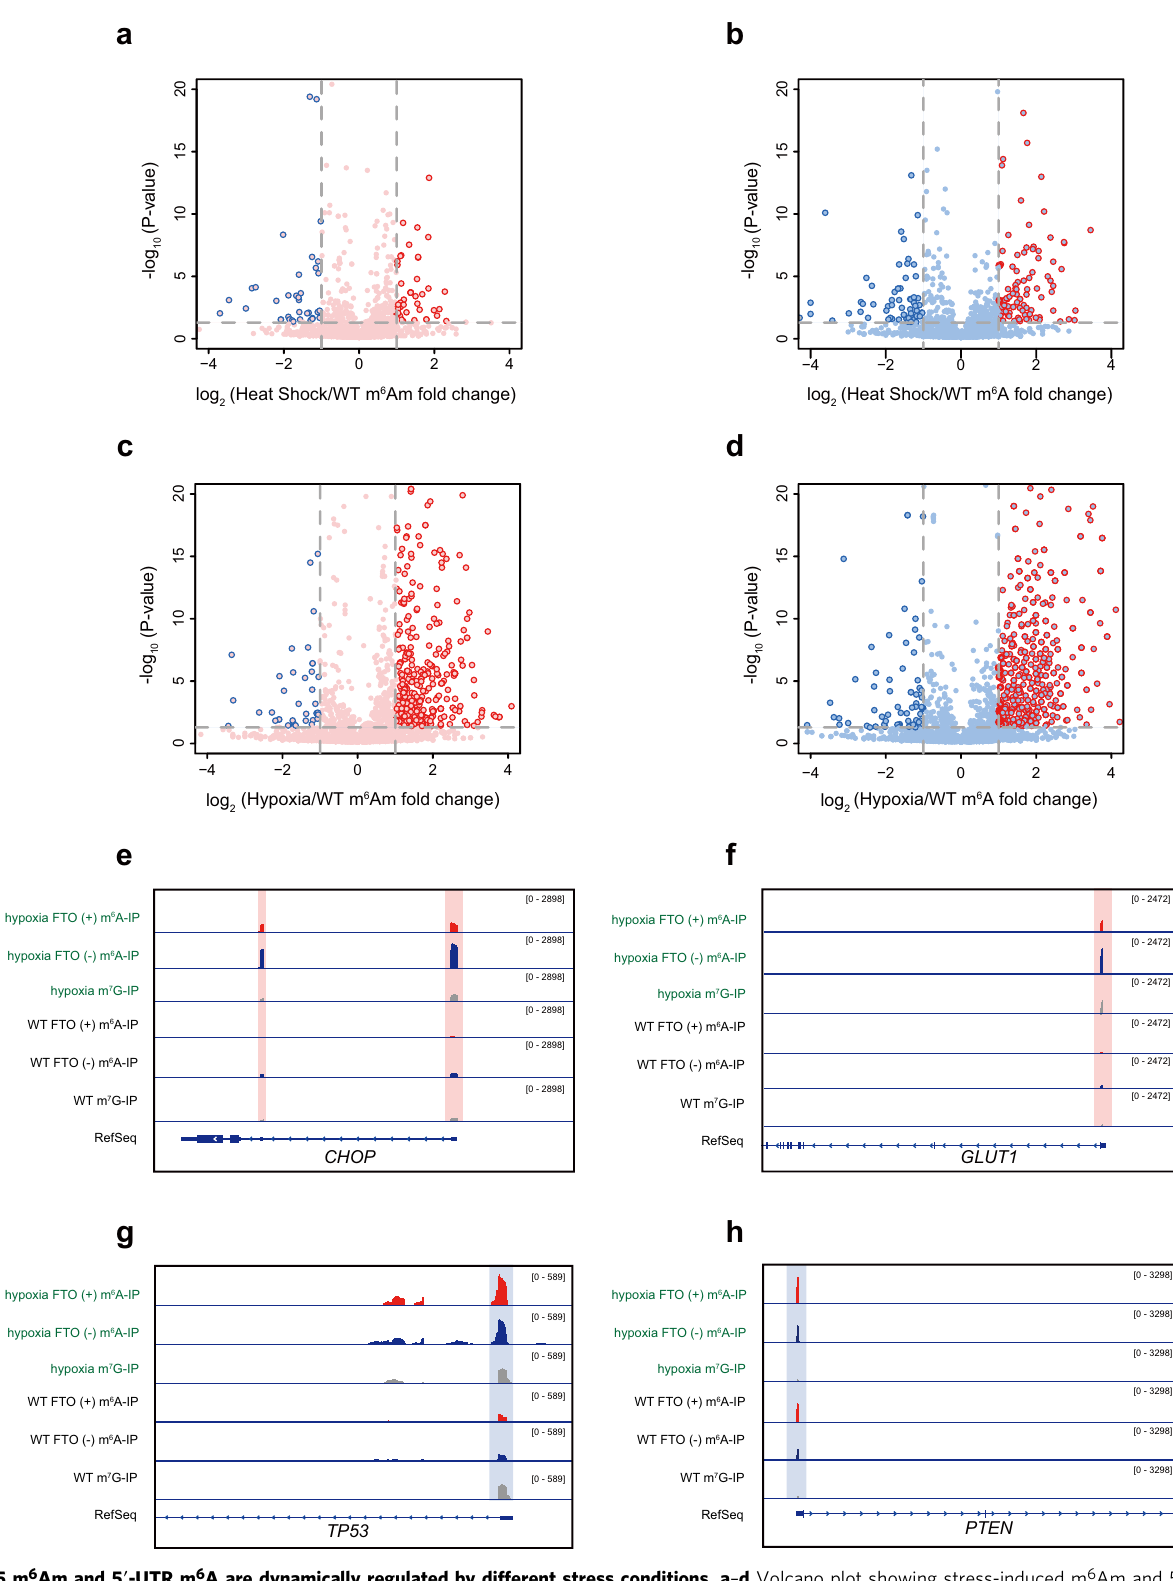
Fig. 5 m 6 Am and 5 ′ -UTR m 6 A are dynamically regulated by different stress conditions. a – d Volcano plot showing stress-induced m 6 Am and 5 ′ -UTR m 6 A: heat shock-inducible m 6 Am peaks ( a ) and 5 ′ -UTR m 6 A peaks ( b ), and hypoxia-inducible m 6 Am peaks ( c ), and 5 ′ -UTR m 6 A peaks ( d ). Red circles denote stress-upregulated peaks; blue circles denote stress-downregulated peaks. Representative views of elevated m 6 Am peaks in CHOP ( e ) and GLUT1 ( f ) under hypoxia stress. Representative views of elevated 5 ′ -UTR m 6 A peaks in TP53 ( g ) and PTEN ( h ) under hypoxia stress. Pink and blue background colors denote m 6 Am and m 6 A signals,